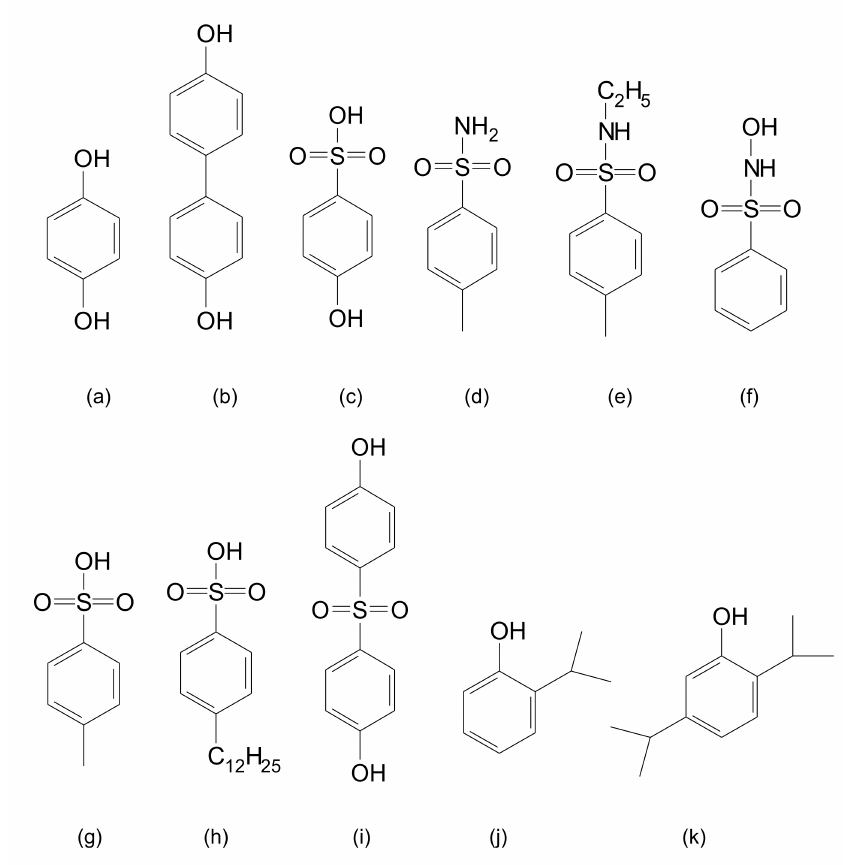
Figure 1. Chemical structures of secondary dopants: ( a ) HQ, ( b ) BP, ( c ) HBSA, ( d ) TSAm, ( e ) E-TSAm, ( f ) HBSAm, ( g ) PTSA, ( h ) DBSA, ( i ) SDP, ( j ) Thymol, and ( k )